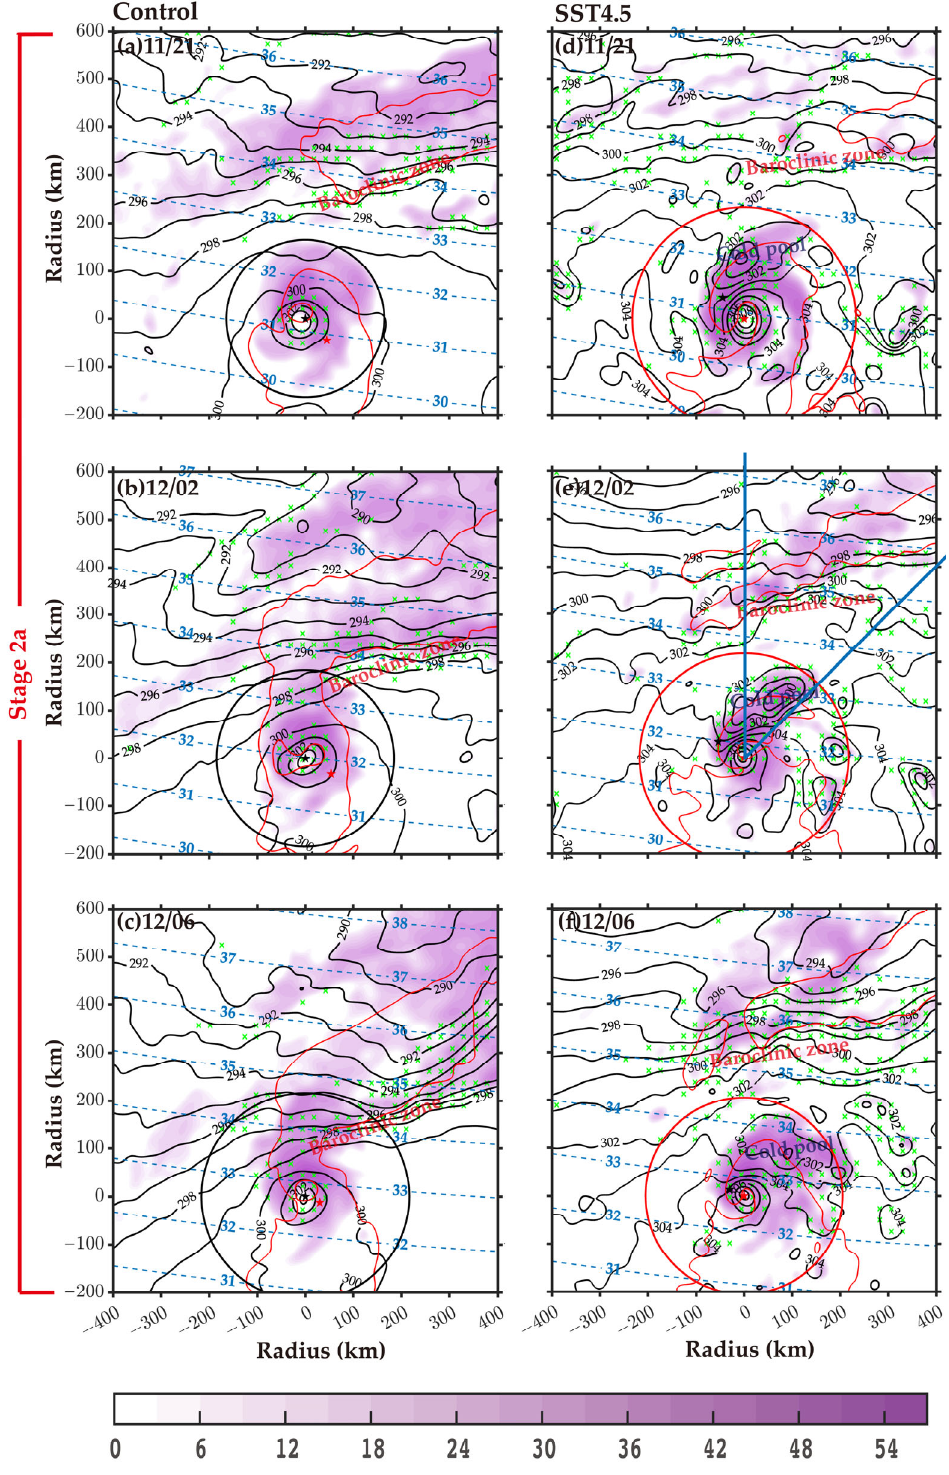
Figure 6. ( a – c ) Horizontal structure of reflectivity (shaded; dBZ), potential temperature (black contours; 1 K interval), and inward radial velocity (red contour at − 12 m s (cid:2879)(cid:2869) ) at the model’s lowest level at 11/21, 12/02, and 12/06 in the control, respectively. ( d – f ) As in ( a – c ) but for SST4.5. The green crosses indicate the approximate region where the potential temperature gradient is above 3 K (100 km) (cid:2879)(cid:2869) . The horizontal and vertical axis indicate the distance (km) from the storm center (black pentagram for the control and red pentagram for SST4.5). The black circle and red circle indicate cyclone R17 in the control and SST4.5, respectively. The dark blue dashed contours indicate latitudes. The words “Baroclinic Zone” and “Cold pool” indicate their approximate locations. Two dark blue